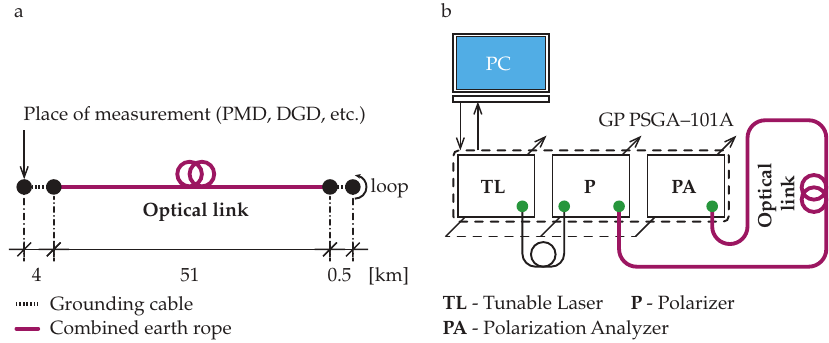
Figure 3. ( a ) Schematics of the back-to-back optical link used in experiments. ( b ) Optical test set-up used to measure parameters of the optical link.